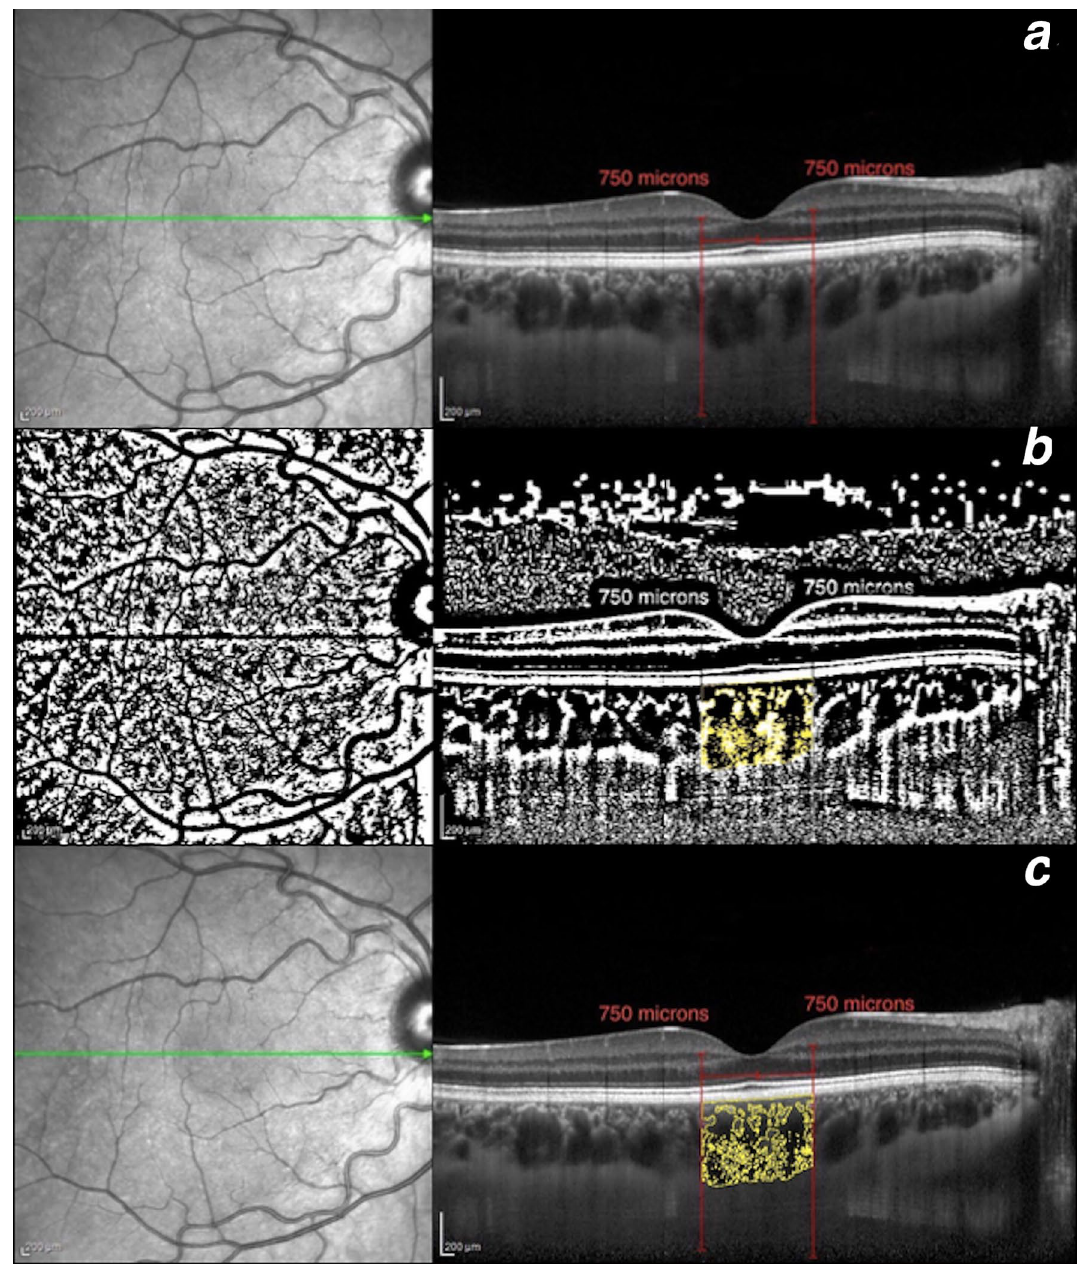
Figure 2. Choroidal vascularity index calculation in a healthy volunteer. ( a ) Determination of the subfoveal choroidal region in the original EDI SD-OCT image with the built-in software of the device. ( b ) Identification of the subfoveal luminal and stromal areas using the binarization technique. ( c ) Overlay of the target choroidal region created by image binarization on the EDI SD-OCT